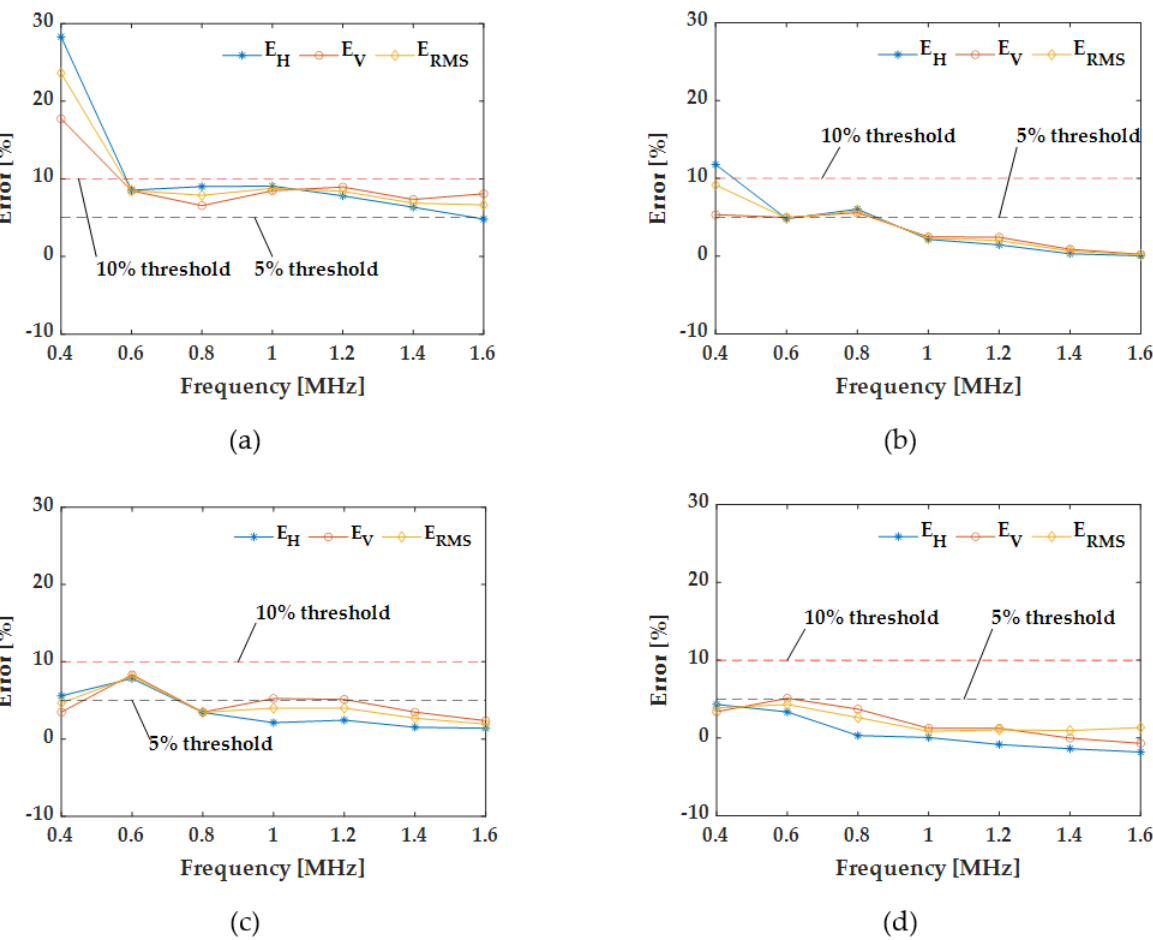
Figure 11. The variation of relative errors of the FWHM as a function of successive-frequency inversions for circular holes: ( a ) 3 mm; ( b ) 4 mm; ( c ) 5 mm; ( d ) 6 mm.